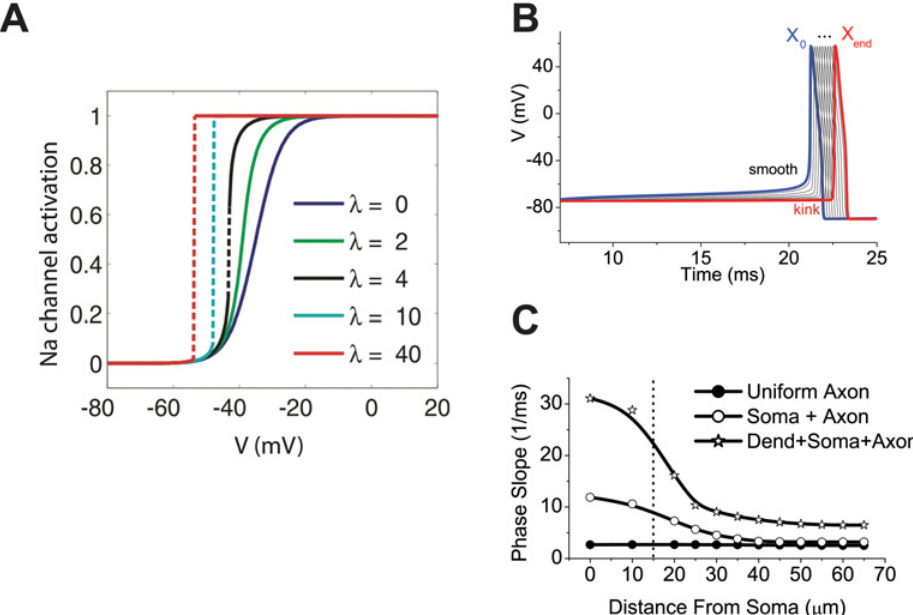
Fig 4. Cooperativity and backpropagation hypotheses. (A) The cooperativity hypothesis (adapted from [40]). Collective activation curve of Na channels as a function of coupling strength λ (0: no coupling). When cooperativity is strong enough, collective activation becomes step-like: Na channels open all at once when a threshold voltage is exceeded. (B and C) The active backpropagation hypothesis (adapted from [39]). (B) When a spike propagates forward along an active 2 mm-long cylinder of 1 μ m diameter (model), its onset becomes progressively sharper. (C) Onset rapidness as a function of distance from soma where the spike is measured, for three models all including a 50 μ m long axon (1 μ m diameter) and a soma: soma with the same diameter as the axon ( “ Uniform axon ” ), large soma ( “ Soma+Axon ” ), and large soma and dendrites ( “ Dend +Soma+Axon ”